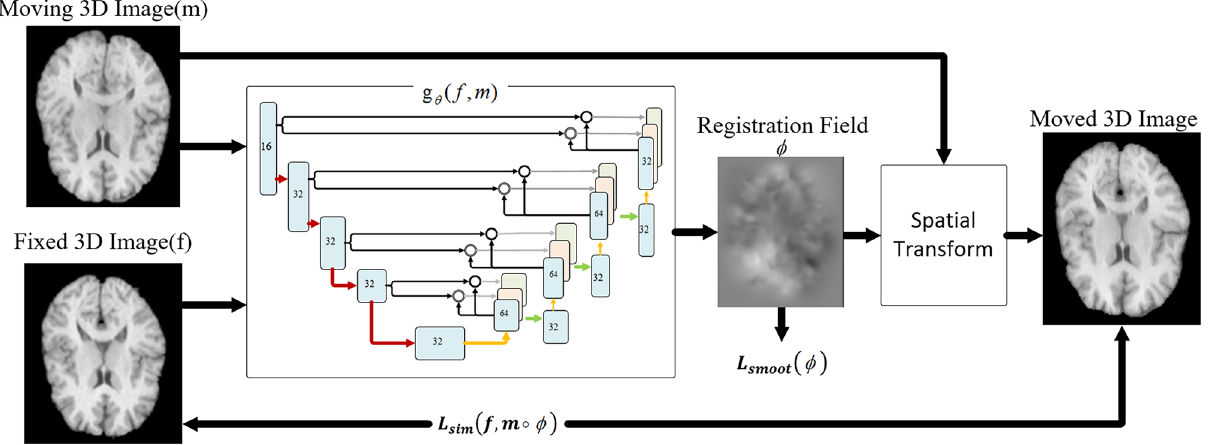
Figure 5. The overview of DAVoxelMorph model. We extract features and generate registration field through dual attention CNN architecture, and then register moving 3D image (M) to fixed 3D image (F) through spatial